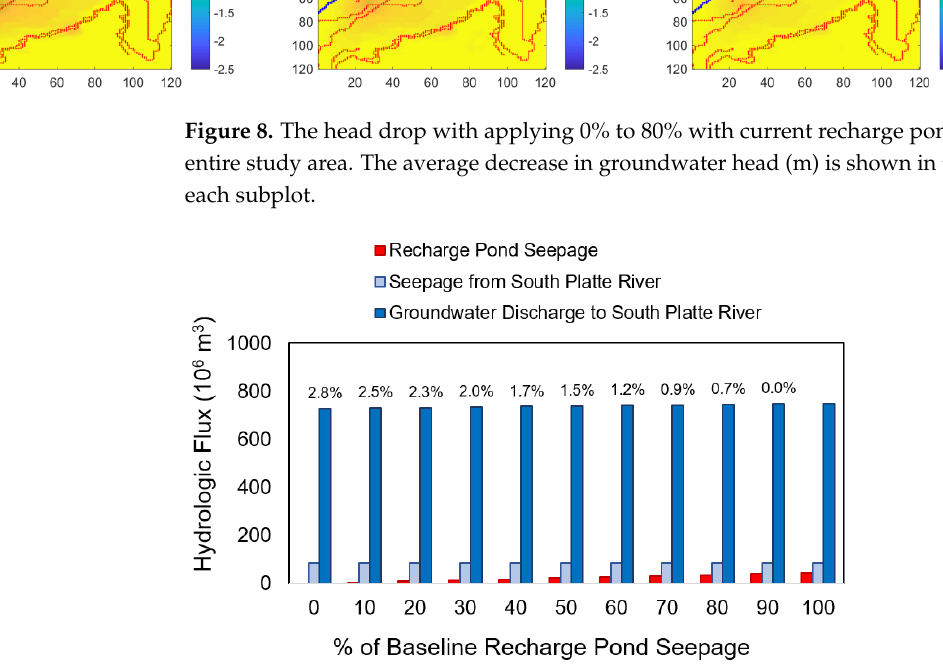
Figure 10. Time series of percent of return flow decreased corresponding the % decrease in recharge pond seepage in the model domain. The impact of each individual recharge pond is also assessed. Figure 11A shows the average head decrease over the study region as each recharge pond is removed from the system. Pond #28 has by far the largest impact on groundwater head. Figure 11B shows the head drop map corresponding to a removal of Pond #28 from the groundwater system. The groundwater head decreases by 2 m in the localized area around the recharge pond. Figure 12 shows the impact of each individual recharge pond on groundwater discharge to the South Platte River. Pond #28 has the largest impact on groundwater discharge, with a daily average decrease of 6674 m 3 /day when this pond is removed from the system.